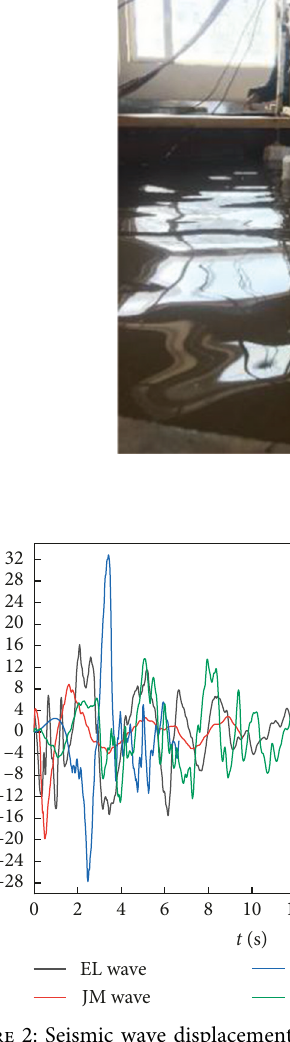
Figure 3: Table-top output acceleration peak. Note . Pasadena wave with an extremum acceleration of 0.4g exceeds the mesa